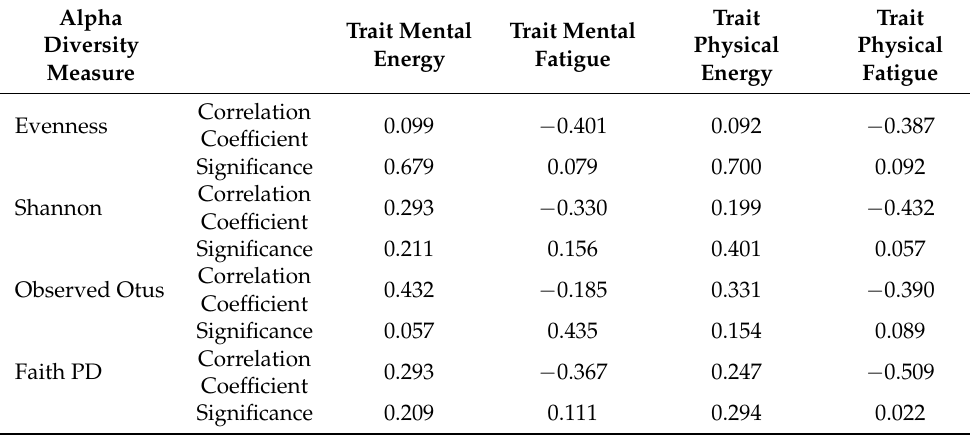
Table A2. Correlation of trait measures with four alpha diversity